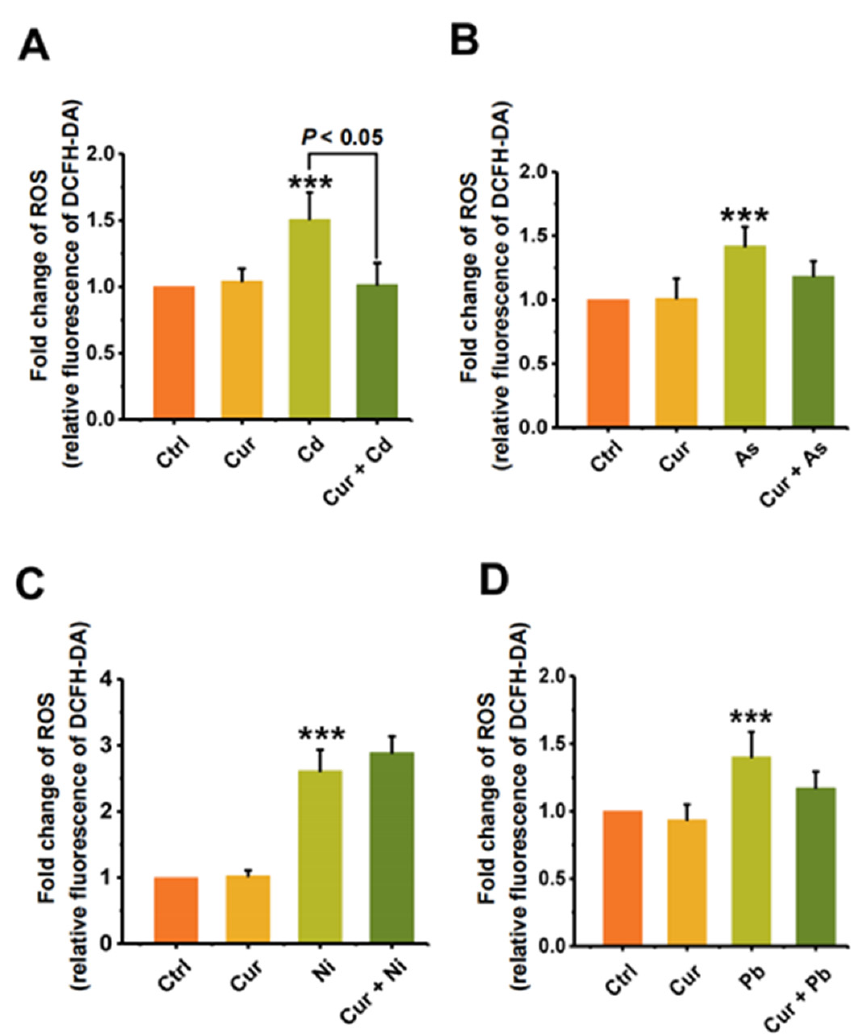
Figure 6. The protective effect of curcumin on the oxidative stress induced by heavy metals ( n = 3). The ROS production of ( A ) Cd-, ( B ) As-, ( C ) Ni- and ( D ) Pb-treated cells with and without curcumin co-incubation. The concentrations of curcumin and heavy metals were 20 µ M for curcumin, 6 µ M for Cd, 100 µ M for As, 2 mM for Ni and 2.5 mM for Pb, separately. *** p < 0.001, compared to the untreated